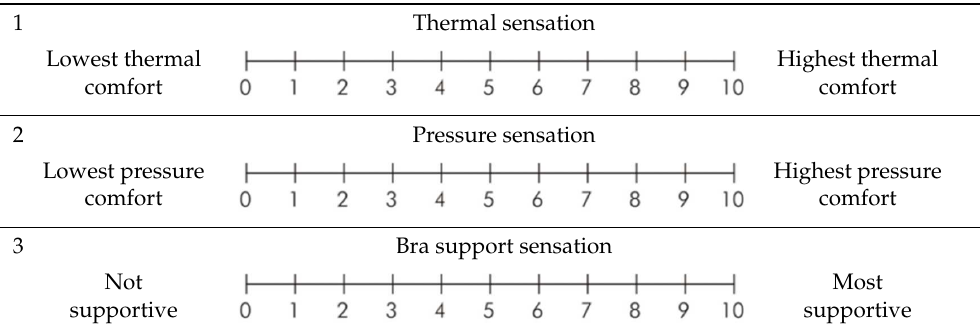
Table 2. Subjective Sensation Rating.